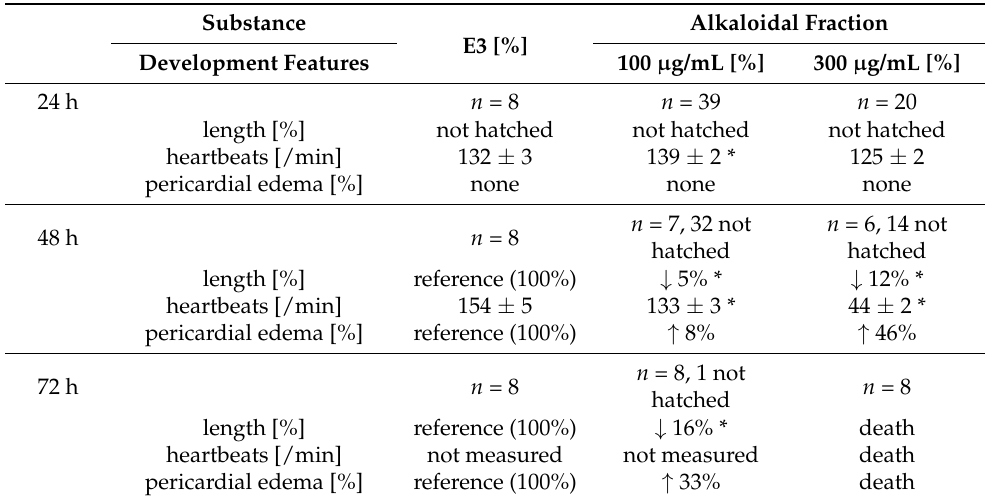
Table 3. Toxicological effects during 72 h embryonic development of Danio